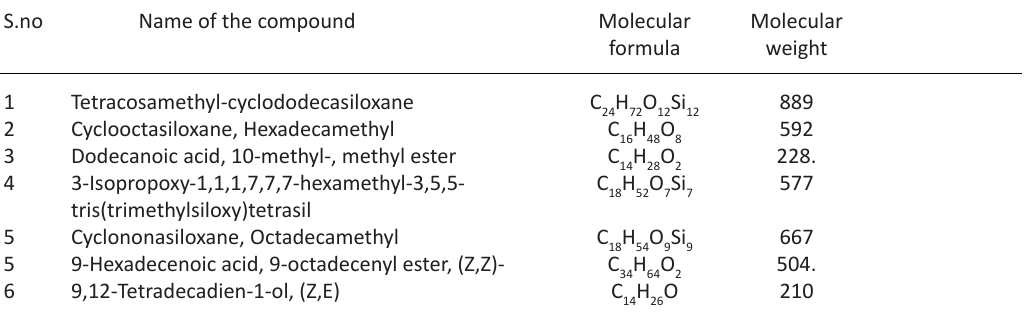
Table 5. Chemical compounds identified from the GC-MS analysis of the ethanol extract of passion fruit pulp with seeds